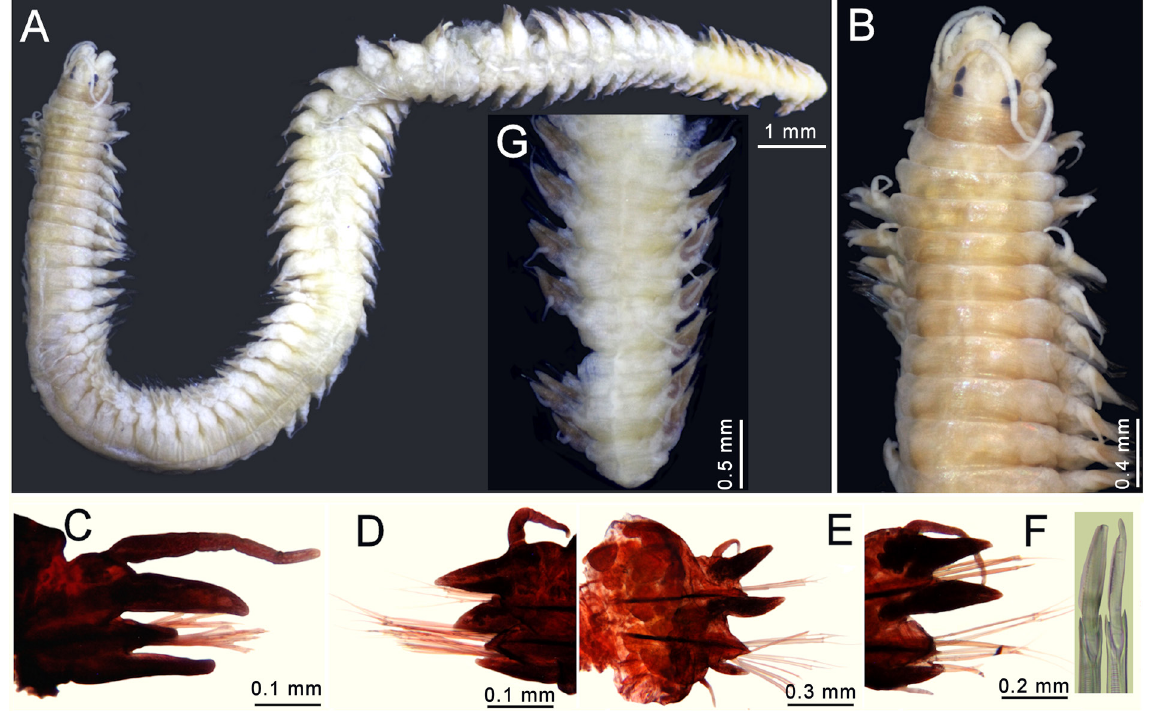
Fig. 18. Nereis mezianei sp. nov., holotype (MNHN 372-4). A . Dorsal view. B . Anterior region, dorsal view. C . Chaetiger 2, left parapodium, anterior view (ventral cirrus lost). D . Chaetiger 16, left parapodium, posterior view (ventral cirrus lost). E . Chaetiger 31, right parapodium, posterior view (notopodial homogomph and supracicular heterogomph falcigers broken). F . Chaetiger 55, right parapodium, posterior view (insets: homogomph falcigers tips). G . Posterior region, dorsal